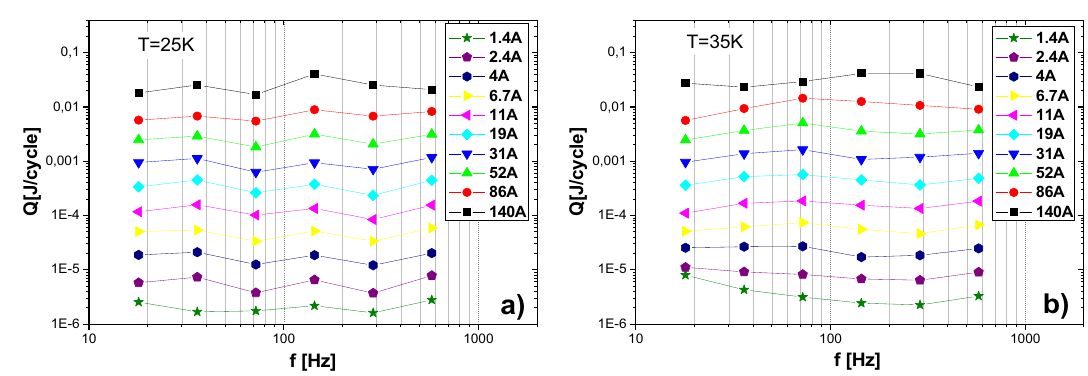
Figure 5. Frequency dependence of transport AC loss per unit cycle of the coil at temperatures 25 K and 35 K.